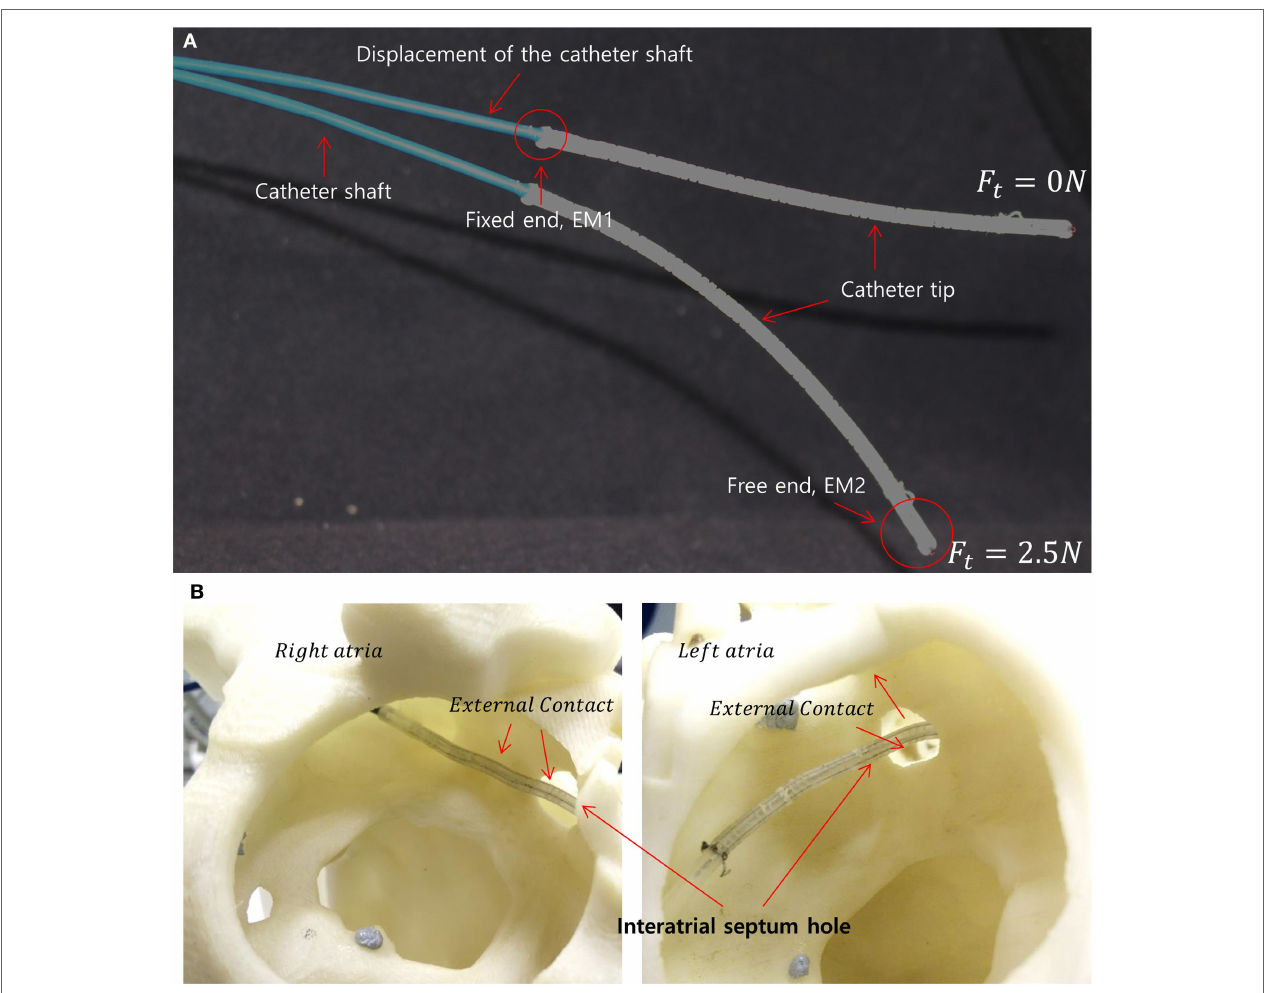
FigUre 1 | (a) Two different catheter shapes under different tension magnitudes indicating the catheter shaft displacement under the increasing load. The locations of the electromagnetic (EM) trackers in the catheter tip are shown as EM1 and EM2. (B) Example scenario of external loads on the catheter tip due to interatrial hole contact (also known as the trans-septal puncture) and heart chamber